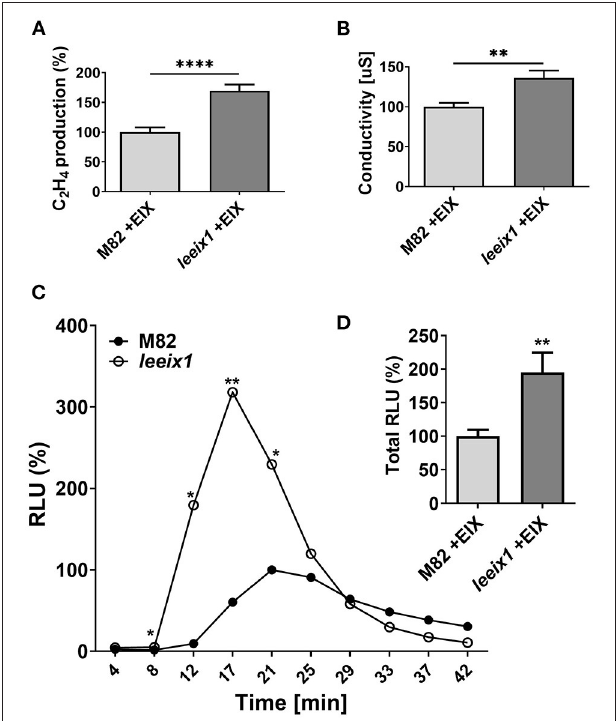
FIGURE 4 | leeix1 mutants have improved defense responses to the Trichoderma elicitor Xyn11/EIX. (A) Ethylene induction after EIX elicitation in M82 and leeix1 was measured using gas-chromatography. M82 average ethylene production was defined as 100%. Average ± SEM of 3 independent experiments is presented, N = 10. Asterisks represent statistical significance in a t -test with Welch’s correction (**** p < 0.0001). (B) Conductivity of M82 and leeix1 samples immersed in water supplemented with EIX for 24h was measured. Average ± SEM of 3 independent replicates is shown. Asterisks represent statistical significance in t -test with Welch’s correction (** p < 0.01). (C) ROS production of WT M82 and leeix1 was measured immediately after EIX application every 4min, using the HRP-luminol method. Average ± SEM of 3 independent experiments is shown, N = 26 per time point. Asterisks represent statistical significance in multiple t -tests (one per time point), * p < 0.05, ** p < 0.01. (D) Shows total ROS production, ** p < 0.01 in a t -test with Welch’s correction, N = 26.